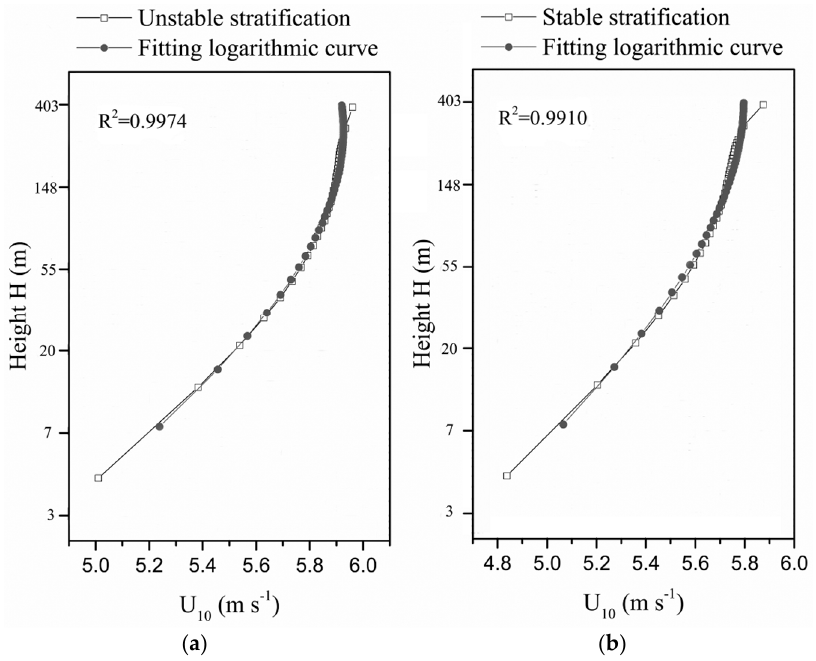
Figure 14. The fitting curves under: ( a ) unstable; and ( b ) stable stratification.